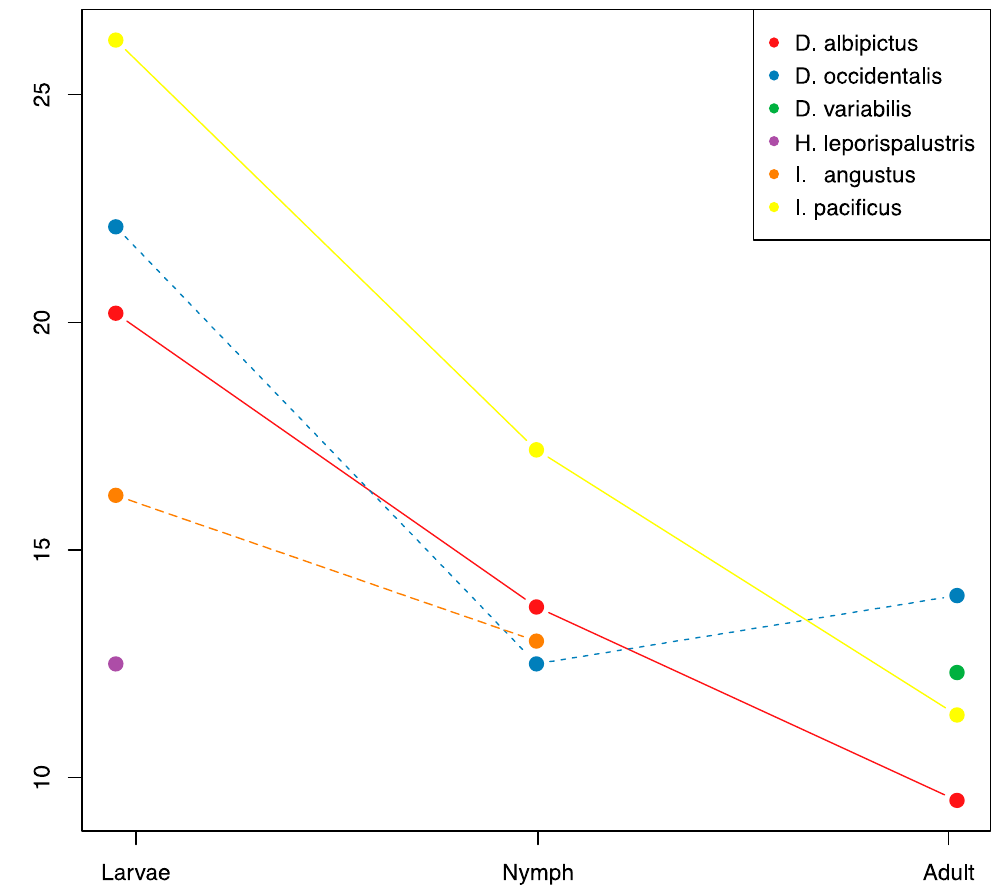
Figure 4. OTU richness through ontogenic development. Mean OTU richness is plotted through life stages for each species with sufficient coverage. Sample numbers for each treatment are listed in Supplementary Table S1.